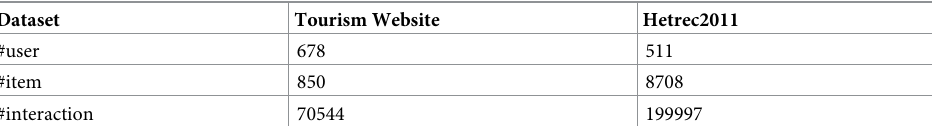
Table 2. Dataset